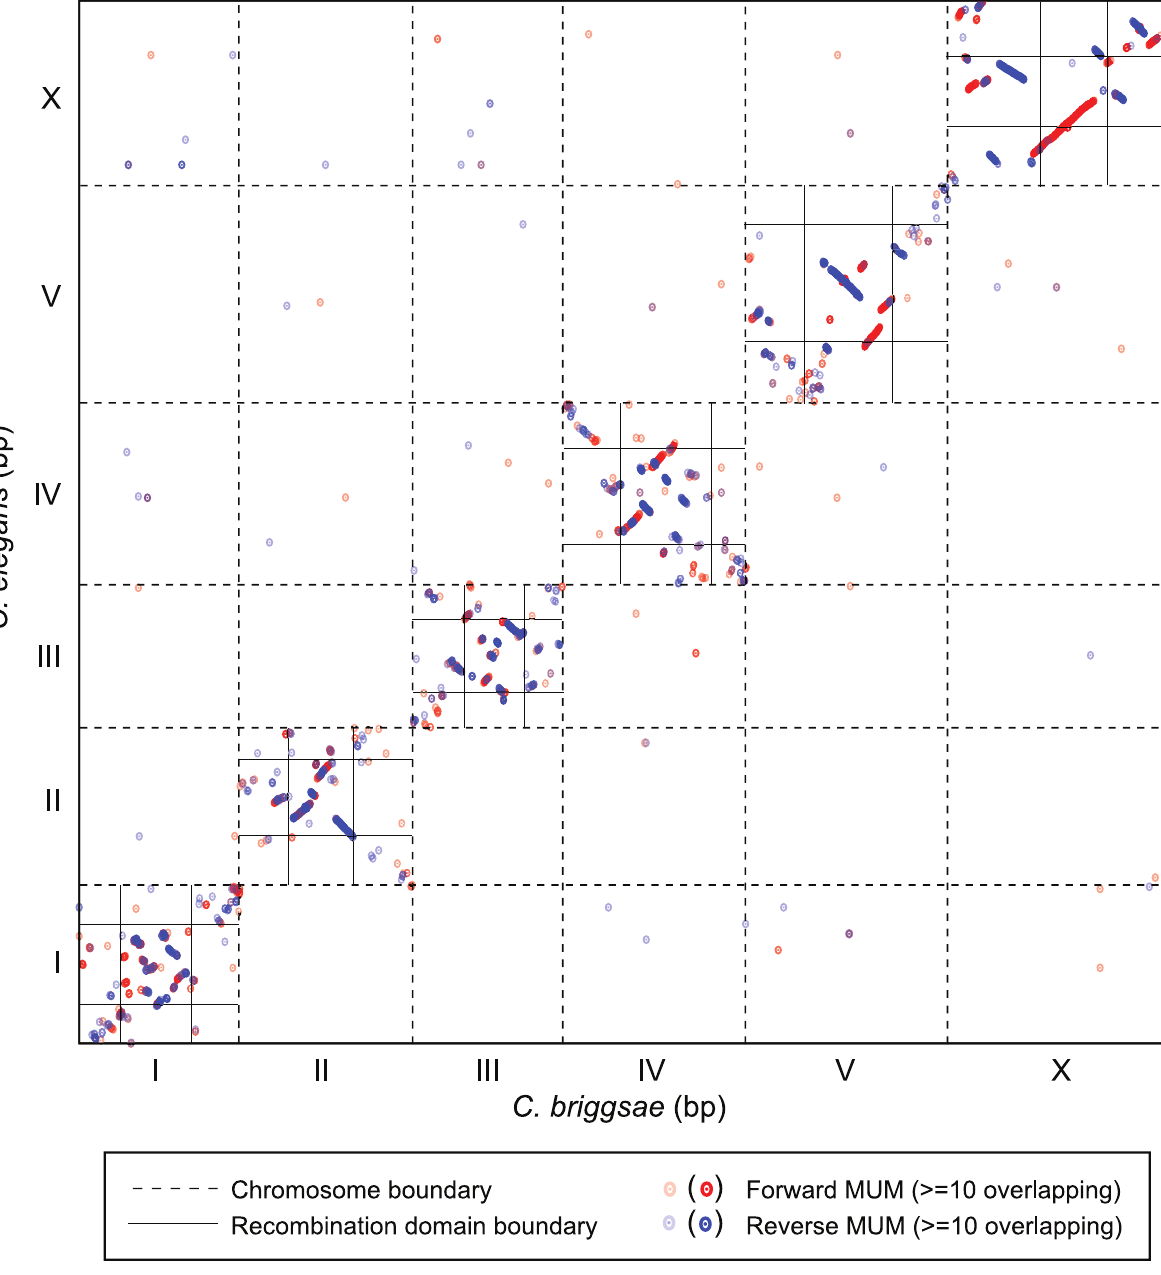
Figure 3. Chromosome synteny between C.elegans and C.briggsae . The concatenated nucleotide sequences of the C. elegans chromosomes were aligned to the concatenated C. briggsae genome. Dashed lines indicate the breakpoints between individual chromosome sequences. Maximal unique matches (MUMs) are depicted as dots: red indicates forward matches; blue indicates reverse matches. The lightest colors indicate a single MUM; the darkest colors indicate . =10 adjacent MUMs that are not spatially resolved here. Vertical and horizontal black lines in the self diagonal indicate the positions of the recombination domain boundaries for C. elegans [15] and for C. briggsae . Extensive synteny is evident in the low- recombining central domains of all chromosomes; synteny is not apparent when comparing the chromosome arms between species. of tip domains on the B arms of C. briggsae ChrII and ChrV could but 1.06 in C. elegans . Strikingly, genetic and physical length ratios represent real diversity or be due to poor marker coverage in those do not always correlate. C. briggsae ChrIV arms have the largest regions. asymmetry in physical length (1.59-fold) but the smallest in genetic length (1.17-fold). The opposite pattern is seen in C. elegans , whose ChrIV arms have a physical length ratio of 1.18 but a genetic length ratio of 1.82. Arm ratios for the X are similar between the arm genetic lengths vary more between species. For example, the two species. ratio of genetic lengths of the two ChrII arms is 1.45 in C. briggsae ,